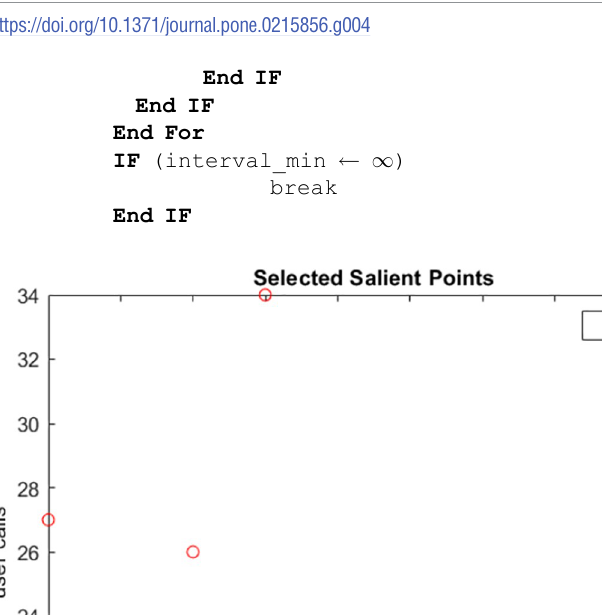
Fig 4. The calling activity of a user.